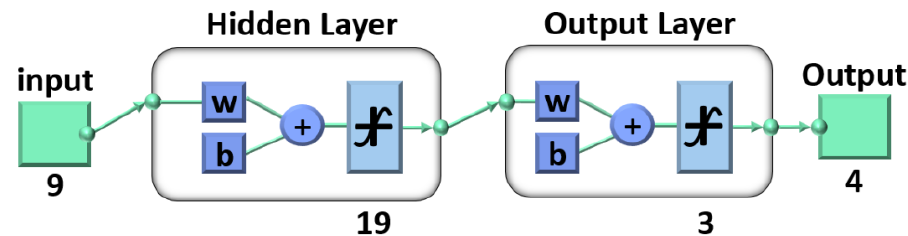
Figure 9. Design diagram of BP neural network model.